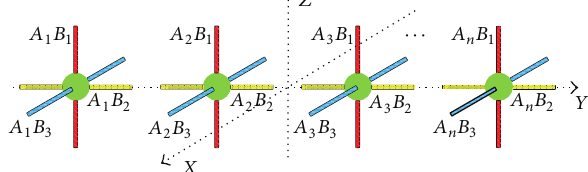
Figure 5: 𝐴 & 𝐵 multiple antenna configuration of the triple- polarized dipole ULA.